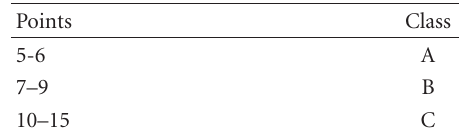
Table 2: Interpretation of the Child-Pugh